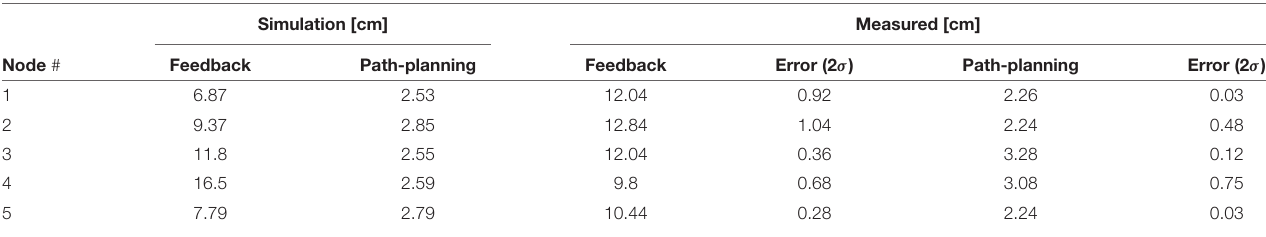
TABLE 2 | Columns 2–3: Least-squares values of end-joint positions from simulations of the feedback method and the path-planning method. Simulation [cm] Measured [cm] Node # Feedback Path-planning Feedback Error (2 σ ) Path-planning Error (2 σ ) 1 6.87 2.53 12.04